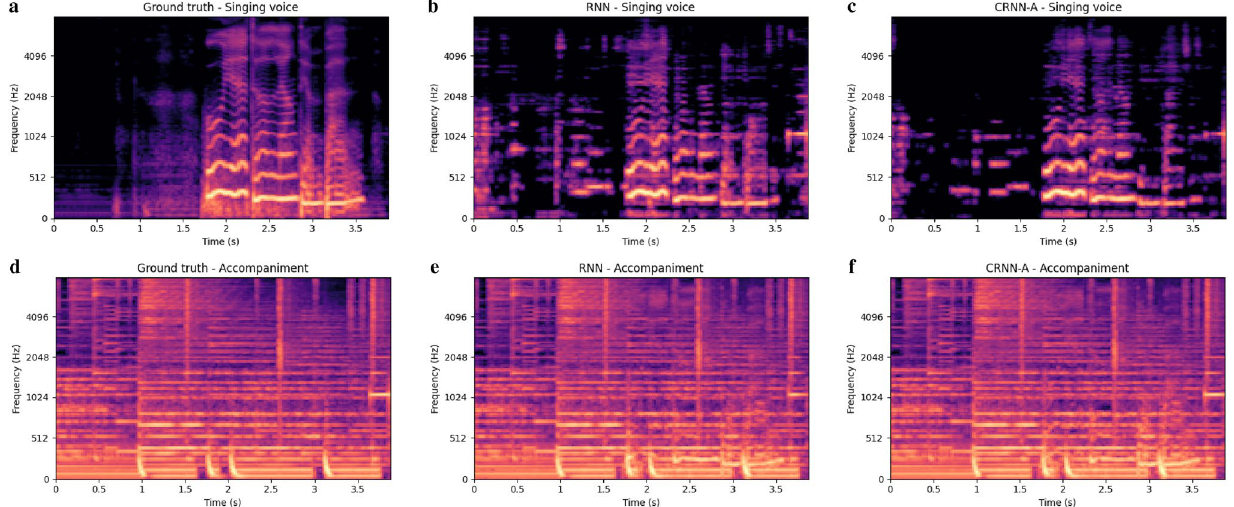
Figure 9. Taking the annar_3_05.wav signal in MIR-1K dataset as an example, the horizontal axis represents time and the vertical axis represents frequency. ( a ) is the ground truth singing voice signal, ( d ) is the ground truth accompaniment. ( b ) and ( e ) are respectively the singing voice signal and accompaniment signal predicted by RNN. ( c ) and ( f ) are respectively the singing voice signal and the accompaniment signal predicted by our CRNN-A.